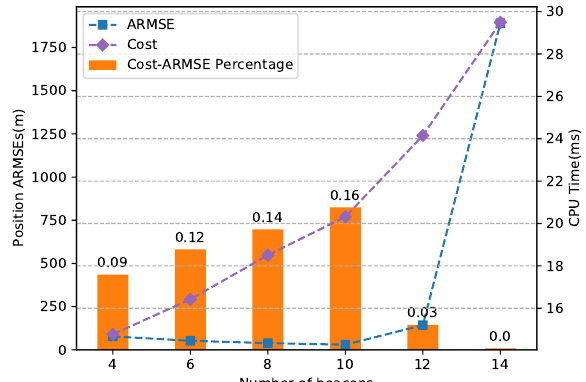
Figure 11. Comparison of the position estimation accuracy from different numbers of beacons.